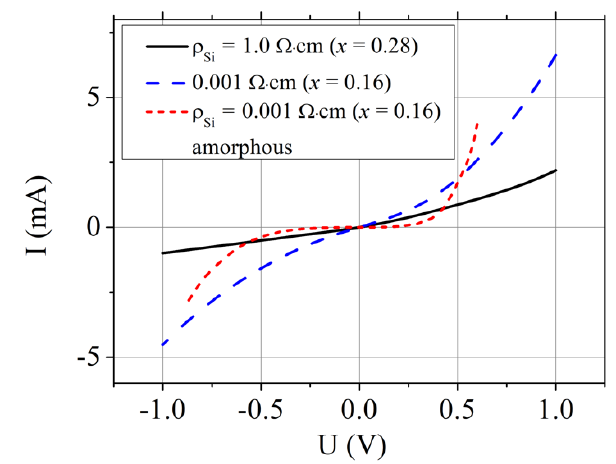
Figure 7. Current–voltage characteristics of TiO 1 − x Nb x O 2 / p -Si heterojunction device measured at room temperature. Solid curve is for x = 0.28 and low conductivity p- Si.